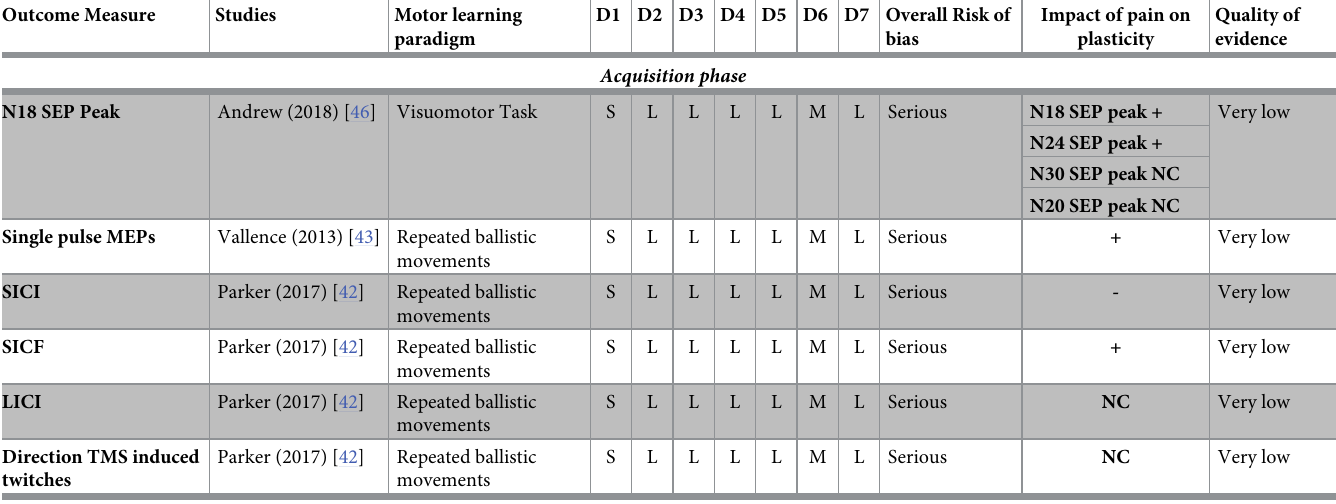
Table 7. Synthesis of evidence, risk of bias judgements and quality of evidence scores for the impact of clinical pain on individual activity dependent plasticity out- come measures. Outcome Measure